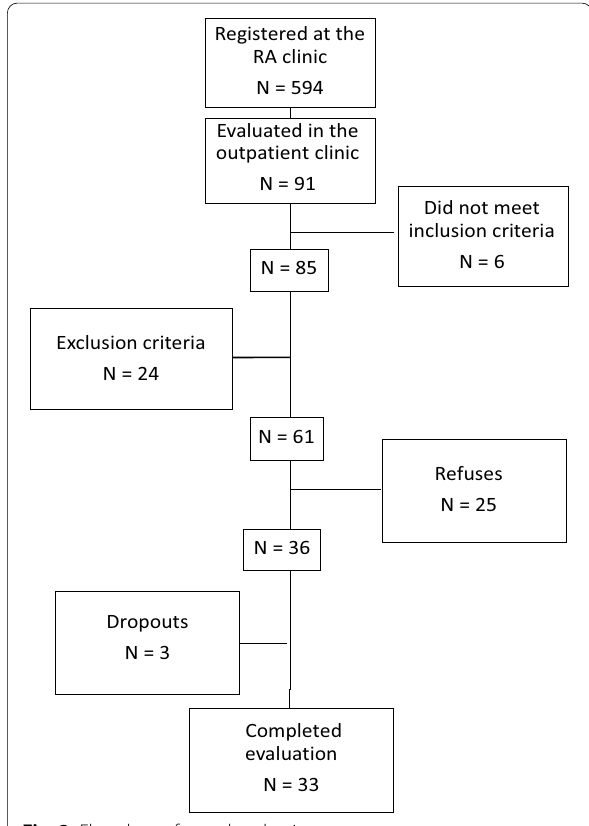
Fig. 2 Flowchart of sample selection